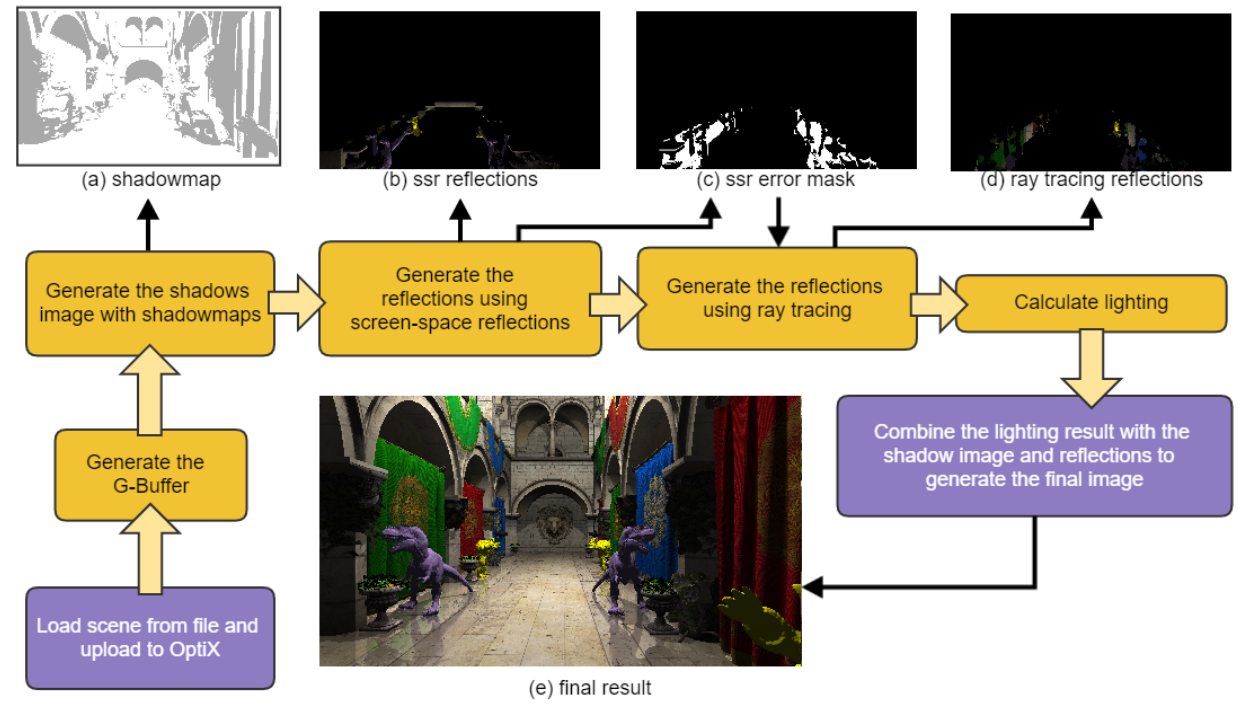
Fig. 3. Execution flow diagram of our rendering engine.